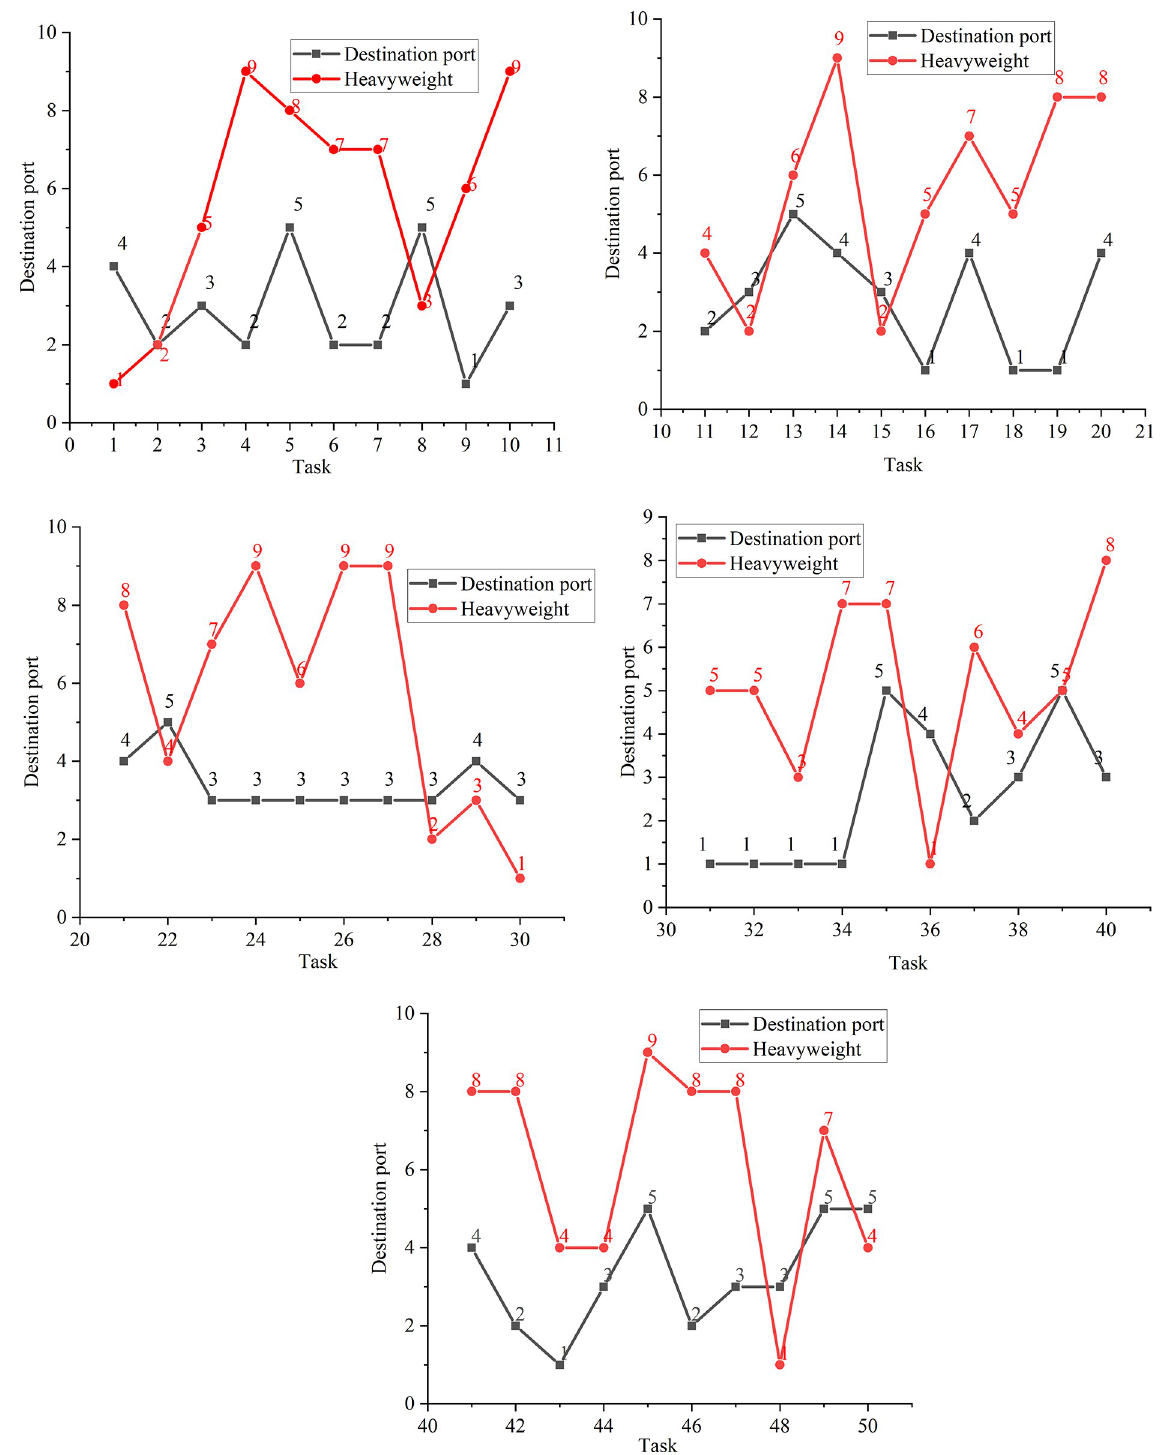
Fig 13. Details of 50 containers in the example. (a) Container 1–10; (b) Container 11–20; (c) Container 21–30; (d) Container 31–40; (e) Container 41–50.